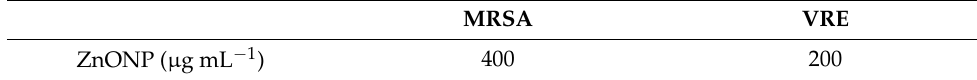
Figure 10. Antimicrobial effects of microalgal synthetized ZnO nanorods. * shows the p value ≥ 0.05 and MIC threshold (green line) at 10% show the lowest concentration in which nanoparticles inhibit the microorganisms’ growth more than 90%. Table 1. MIC values of ZnONP against MRSA and